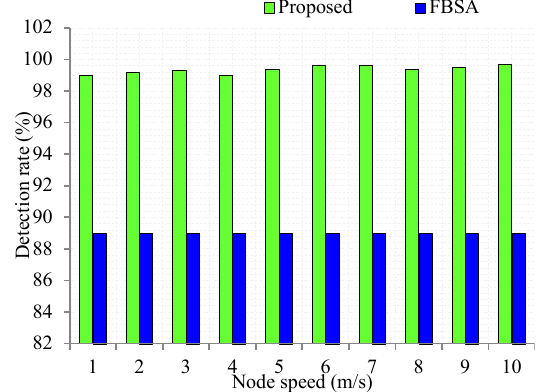
Figure 10 . Comparative analysis on malicious activity